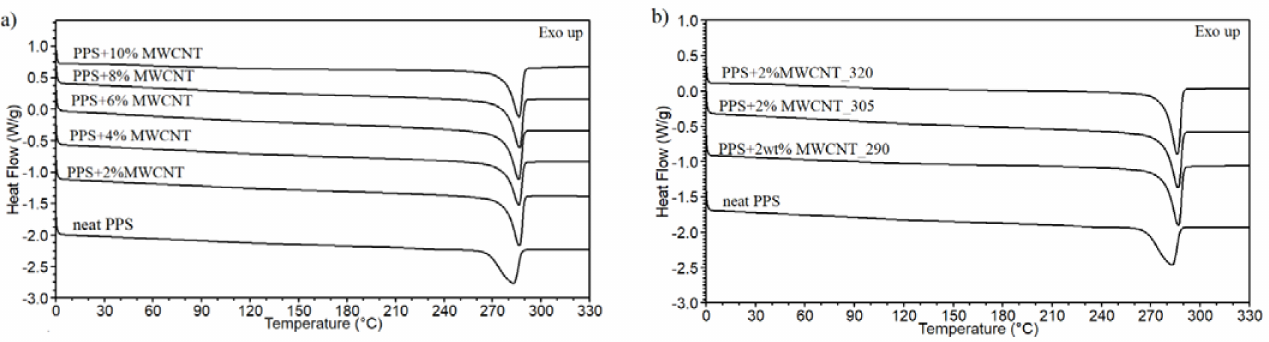
Figure 3. The second heating curve for the PPS/MWCNT composites. ( a ) Comparison of the MWCNT content. ( b ) Comparison of the extrusion temperature.